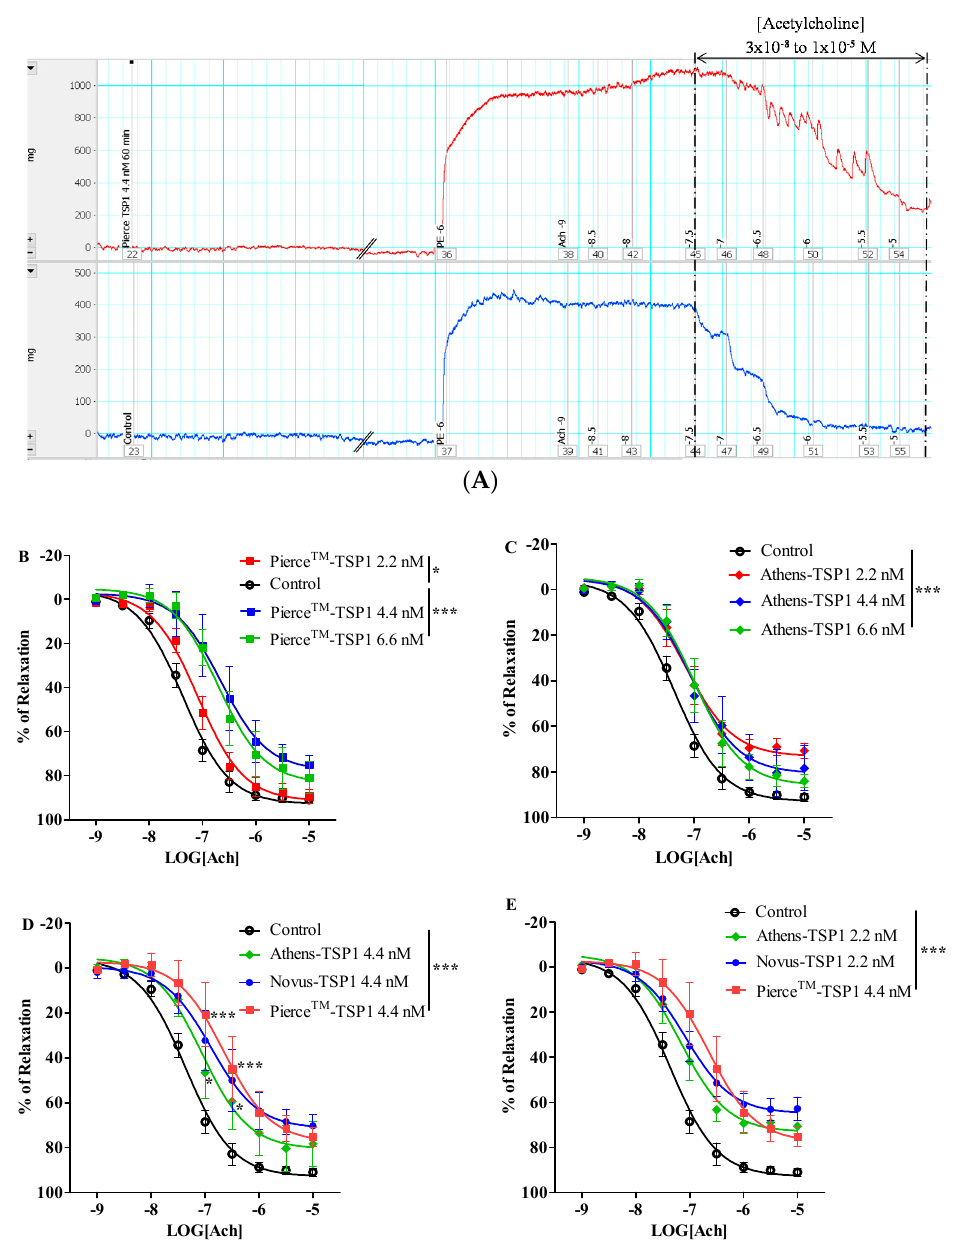
Figure 3. Native thrombospondin 1 (TSP1) from different sources inhibited endotheliumdependent vasorelaxation with different efficacies. ( A ) Representative force vs. time traces recordings of isolated murine thoracic aorta responses to phenylephrine followed acetylcholine stimulations in the presence of Pierce TM —TSP1 or vehicle control, i.e., Krebs